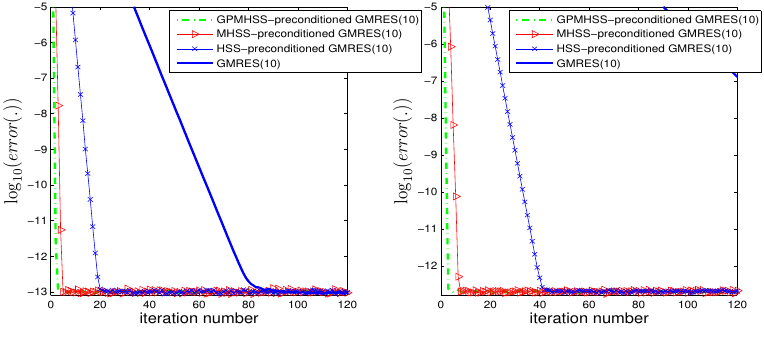
Figure 5. The log 10 of the residual error versus iteration number for Example 1, with n = 20 × 20 (left) and n = 40 × 40